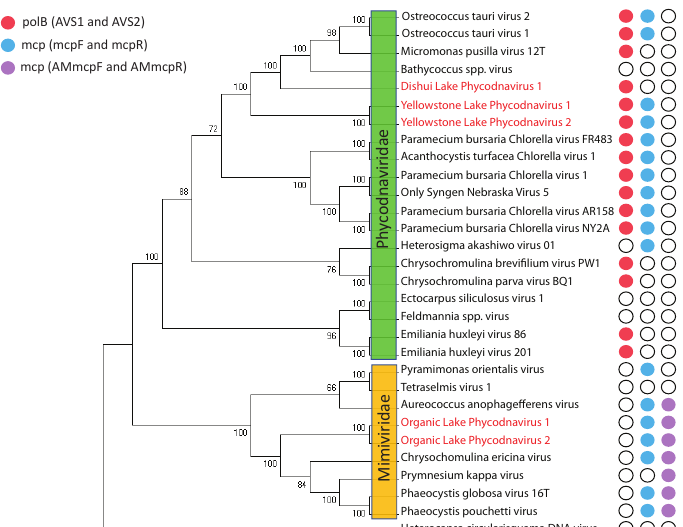
Figure 4. Phylogenetic tree depicting the evolutionary relationships of algal NCLDVs based on amino acid alignment (ClustalW) of the core gene, DNA polymerase B (see in Supplemental Table S2). The tree was built using the maximum likelihood method based on the JTT matrix-based model with 200 iterations in MEGA7 [117]. Viruses belong either to the family Phycodnaviridae or are recognized “extended members” of the family Mimiviridae . The recently discovered dinoflagellate infecting virus, Heterocapsa circularisquama DNA virus, was used to root the tree and shows little similarity to other algal NCLDVs despite being a large DNA virus. Viruses in red text denote metagenome assembled viral genomes, meaning their association with an alga host is putative. Colored dots to the right indicate the viruses can be putatively PCR amplified by the respective PCR primer set based on ≥ 90% match between each primer and its respective target binding site. This equates to ≤ 2 primer mismatches, which has been shown to be capable of producing a PCR reaction, albeit at lower efficiency (for RT-qPCR) [126]. The same study shows that three or more mismatches in the same primer completely inhibit a PCR reaction, and is an observation that aligns with failed PCR reactions reported for Ectocarpus siliculosus virus 1 and Feldmannia spp. virus [11]. PCR amplification predictions were done using motif searches in CLC Genomics and the software De-MetaST-BLAST